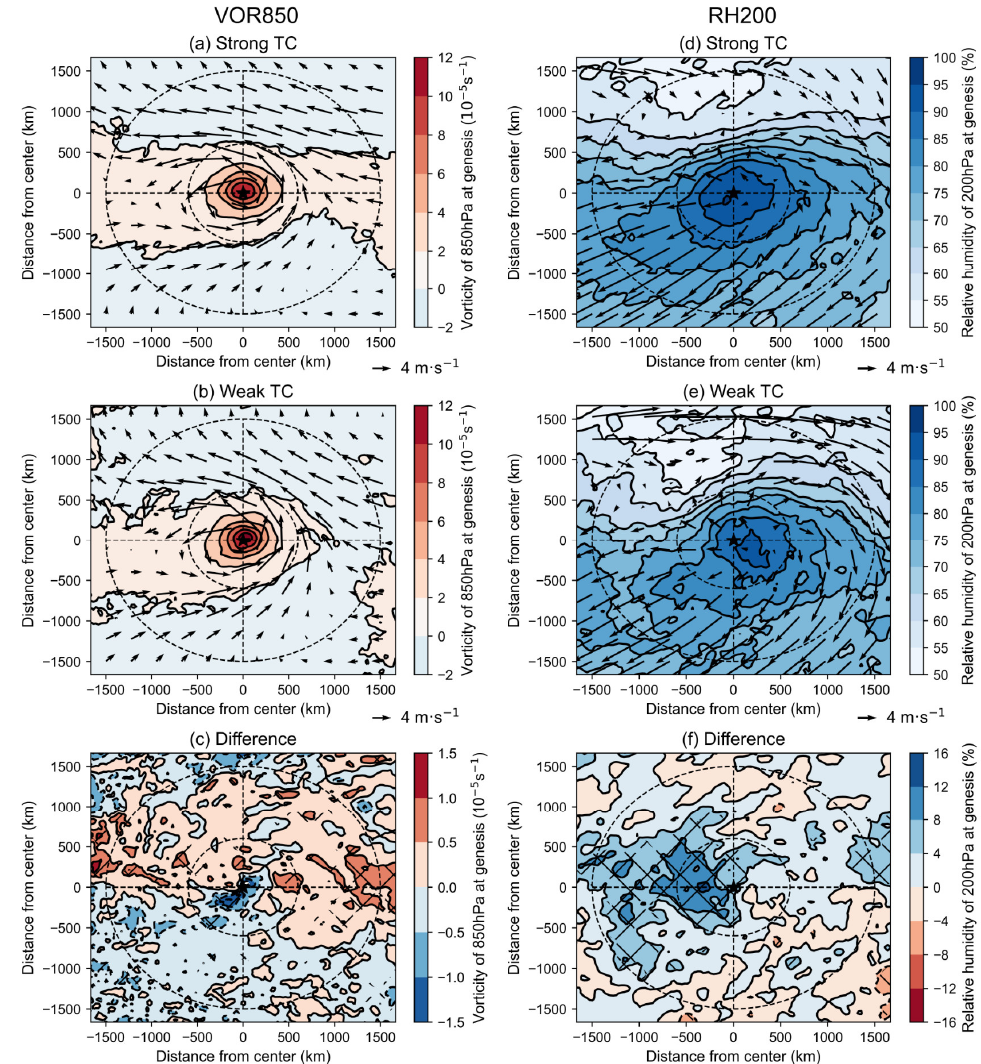
Figure 7. Storm-centered composites of ( a ) relative vorticity (VOR850) by contours with wind vectors at 850 hPa (10 − 5 s − 1 ) and ( d ) relative humidity at 200 hPa (RH200) by contours with wind vectors at 200 hPa (%) for strong TCs at genesis. ( b , e ) are the same as ( a , d ), but for weak TCs. ( c , f ) Difference fields of strong minus weak TCs. Black star represents storm center, and dotted black lines are boundaries of eight sectors discussed in Figure 1. Areas with crossing lines in ( c , f ) depict where differences between two categories are statistically significant at the 95% confidence level.